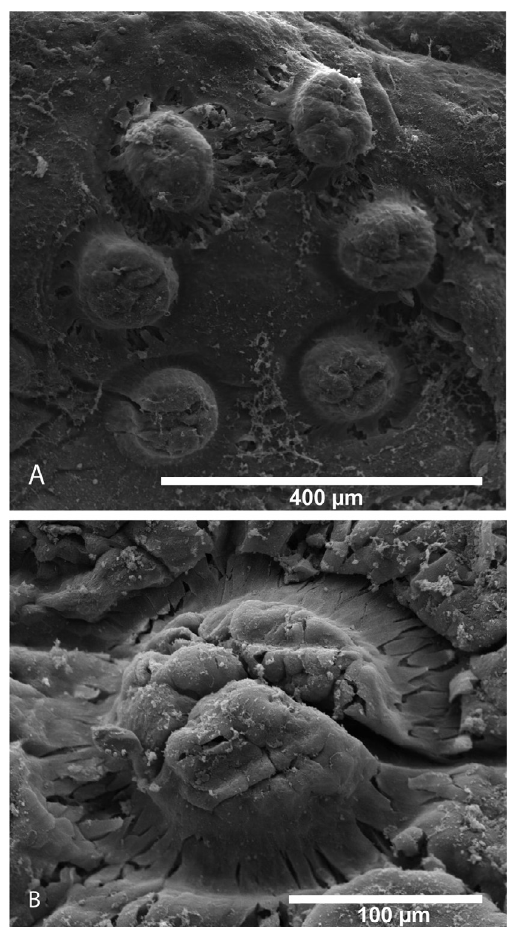
Figure 5. Scanning electron micrographs of buds made by the parasite’s suckers on the host’s bladder surface (A) and high magnification of a single bud